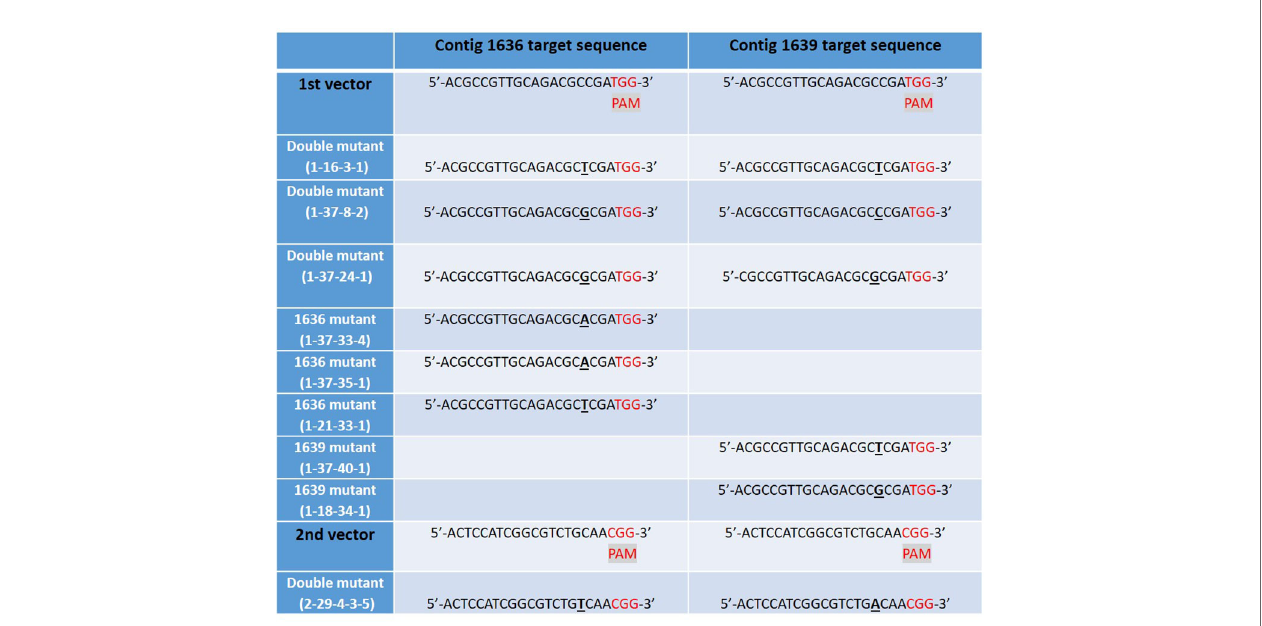
FIGURE 5 | The mutated CRISPR/Cas9 target sites of b -1,3-glucanase gene sequences in nine studied lines of barley cv Golden Promise, derived from fi ve different transgenic plants: 1-16, 1-37, 1-21, 1-18, and 2-29. Single DNA base inserts are shown in underlined bold text and a protospacer adjacent motif (PAM) site in red. Two different vectors were used to generate the mutant lines, each targeting the two b -1,3-glucanase genes 1636 and 1639 resulting in lines with one or both target genes